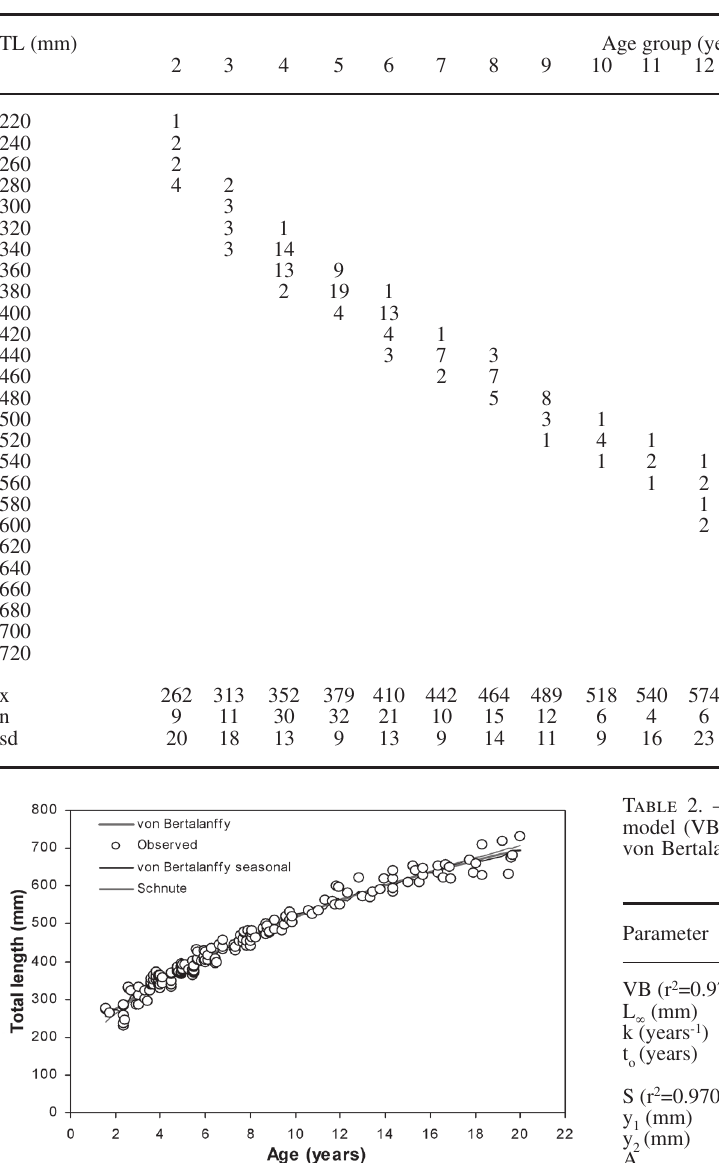
Fig. 6. – observed total length-at-age and relationship of age to total length predicted from von Bertalanffy growth model, schnute growth model, and seasonalised von Bertalanffy growth model (n=188) for Mycteroperca fusca off the canary